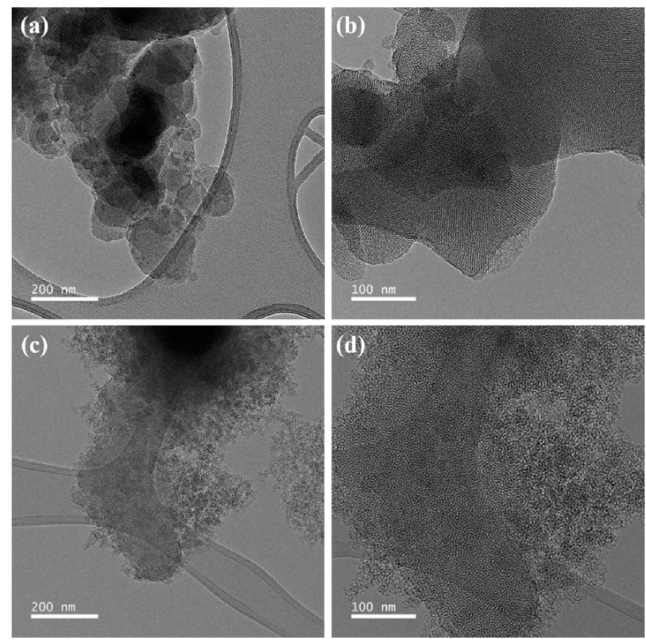
Figure 2. TEM images of the T-MS-0 in ( a , b ) and the R-MS-0 in ( c , d